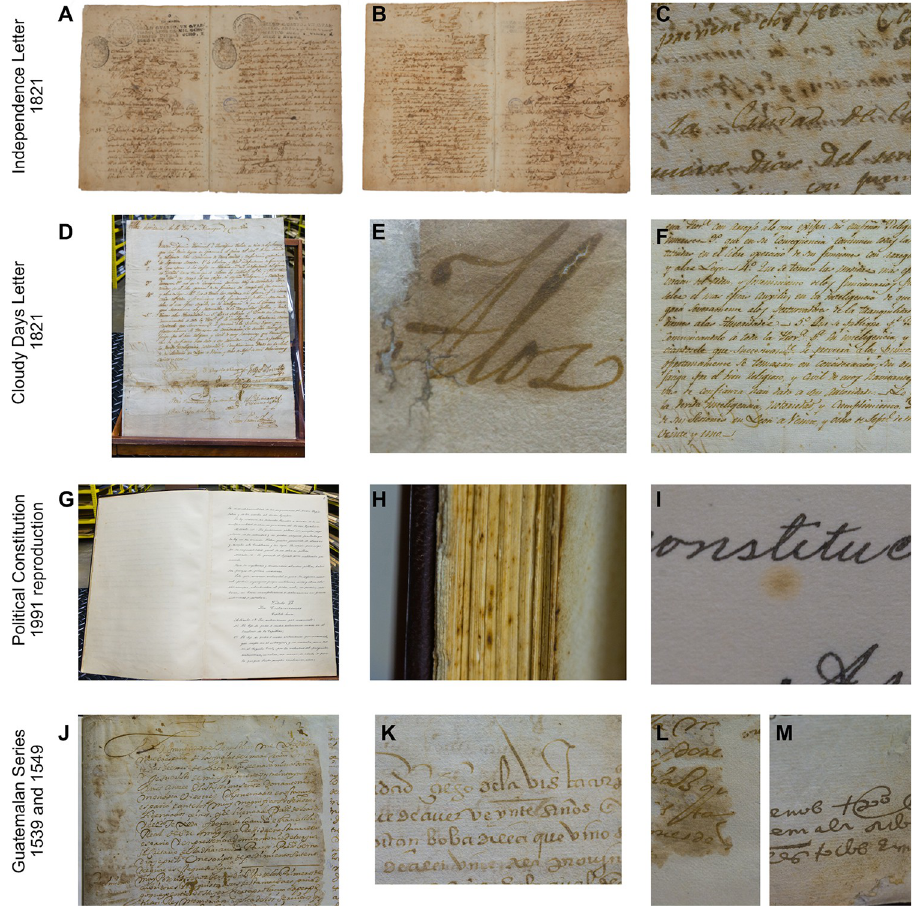
Fig 1. Historic documents from Costa Rica analyzed for chemical and substrate characterization. A,B . Independence Act. C . Signs of deterioration on the Independence Act, including yellow spots around the letters. D . Cloudy Days Act. E . Humidity mark on Cloudy Days Act. F . Oxidation signs around the ink from Cloudy Days Act. G . 1949 Political Constitution (1991 reproduction). H . Signs of microbiological contamination on 1949 Political Constitution (1991 reproduction). I . Yellow spots on 1949 Political Constitution (1991 reproduction). J . Fragment of the 1539 Guatemalan Series. K . Fragment of the 1549 Guatemalan Series. L,M . Signs of leakage and humidity on 1539– 1549 Guatemalan